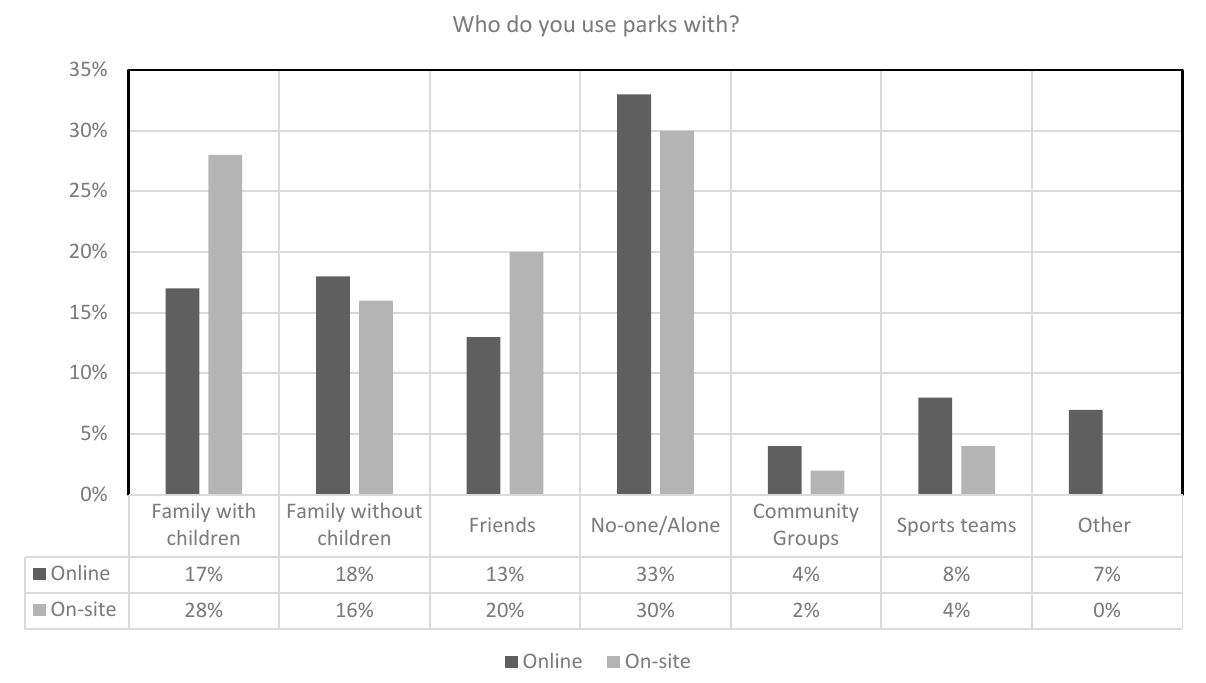
Figure 3. Respondents’ use of parks and who with.